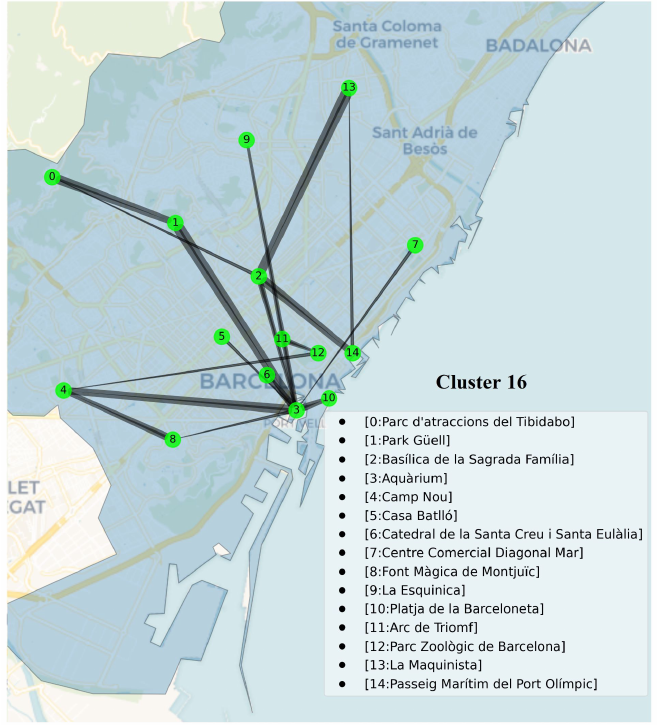
Figure 5. Tourist mobility pattern between attractions in Barcelona for cluster